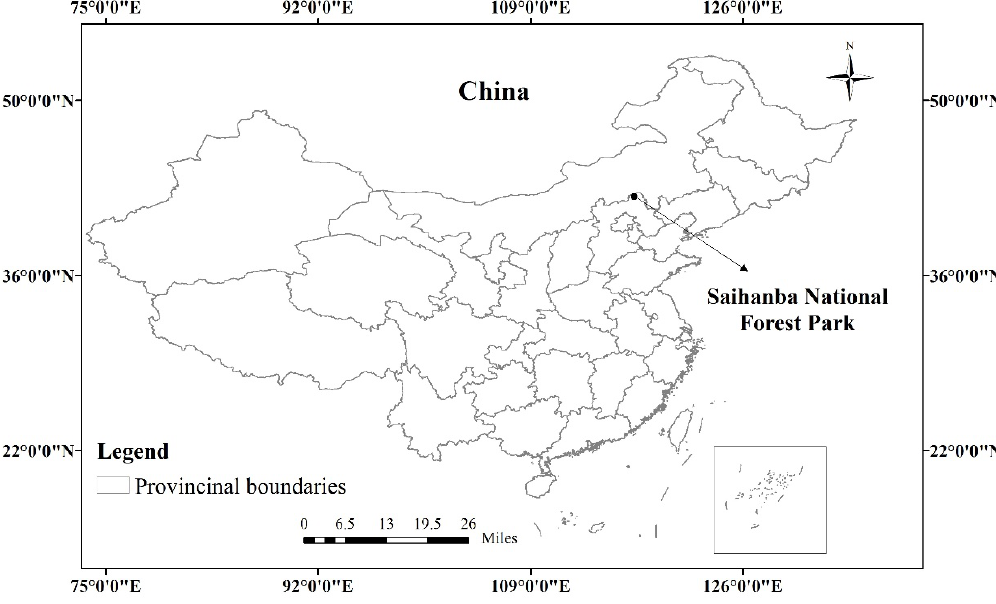
Figure 1. Location of the Saihanba National Forest Park in Hebei Province, China.